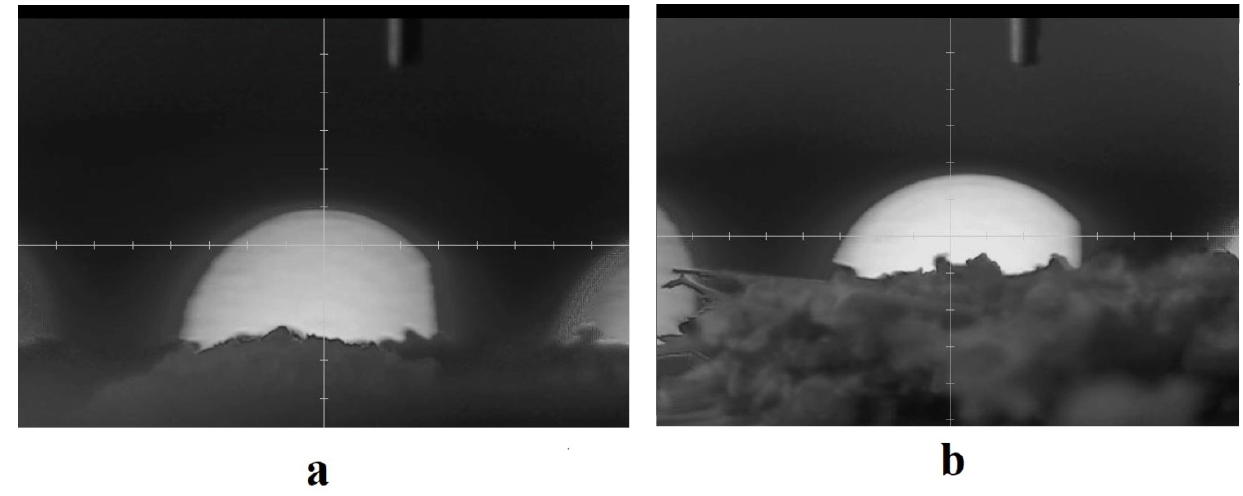
Figure 10. Contact angle for AB adsorbent: ( a ) before adsorption; ( b ) after adsorption.